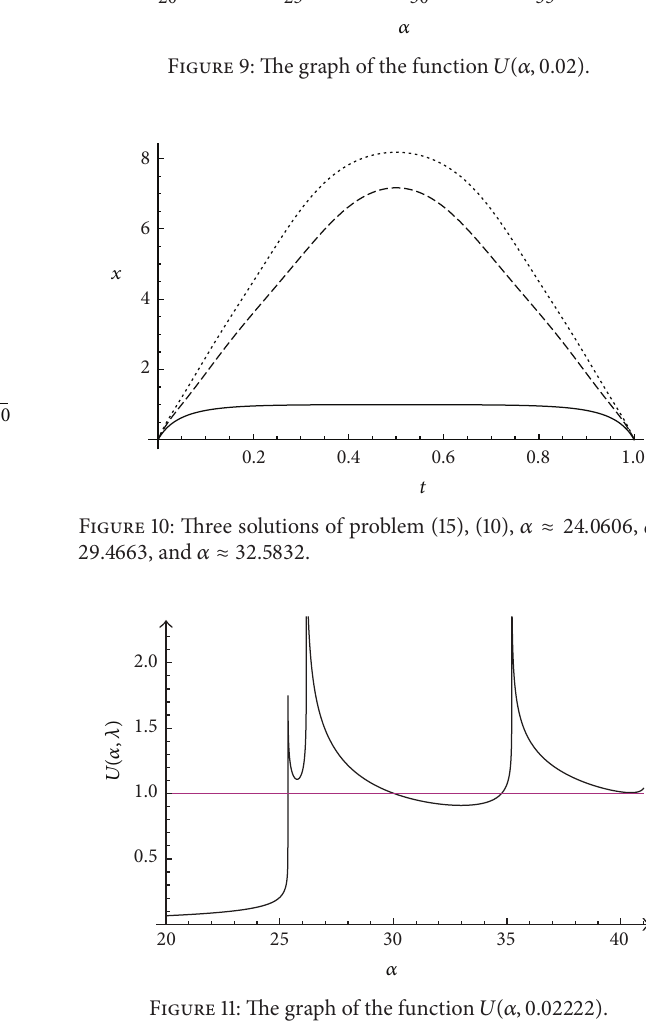
The 012B phase portrait of (18) has 7 critical points; 3 of them are the points of type “center” and 4 are points of type “saddle”: (1, 0) , (5, 0) , (8, 0) , and (12, 0) . The structure of the phase portrait for (18) is the same as that for (15).